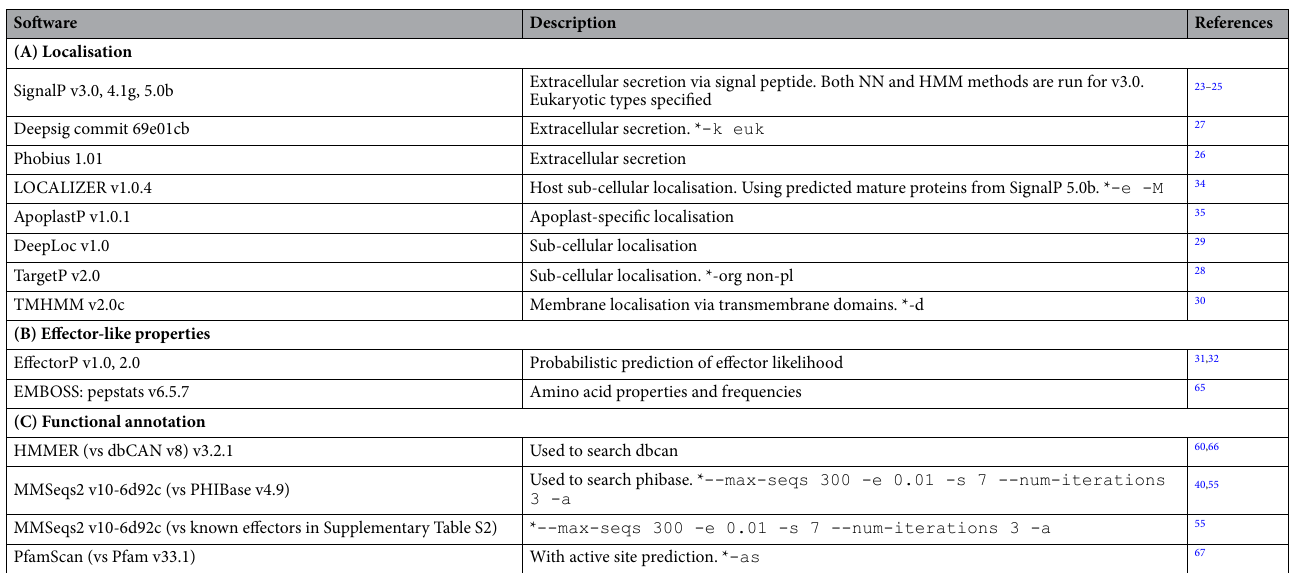
Table 3. Bioinformatics tools and methods integrated into the Predector pipeline. *Non-default parameters are indicated where